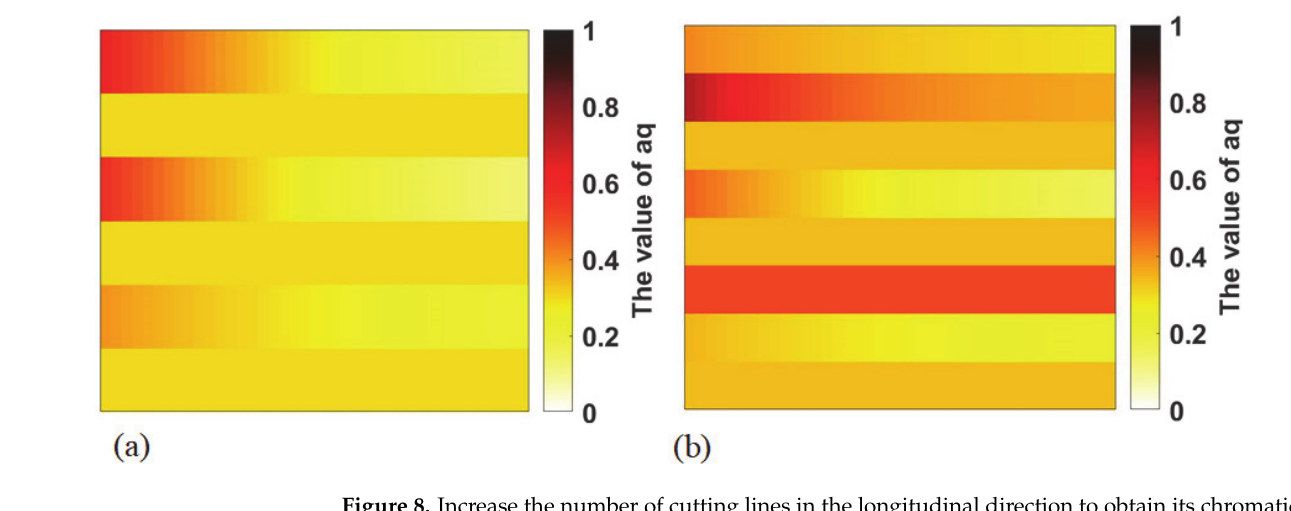
Figure 8. Increase the number of cutting lines in the longitudinal direction to obtain its chromaticity diagram. ( a ) Cut six rows in the longitudinal direction. ( b ) Cut eight rows in the longitudinal direc- tion. Table 2. The test set recognition rate when cutting different numbers of rows .